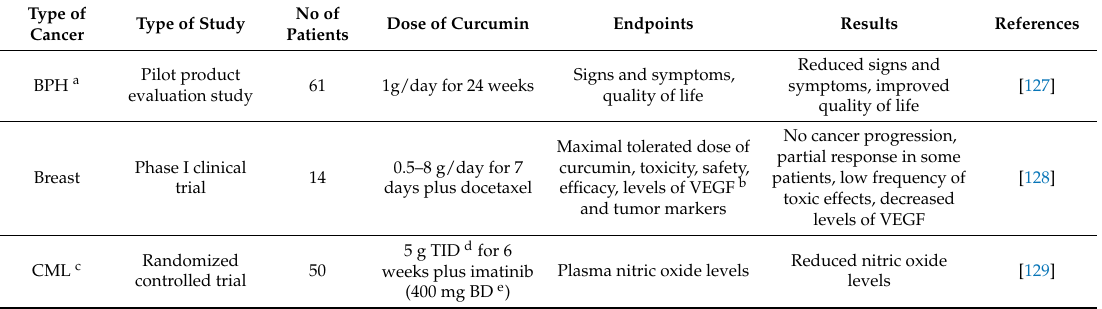
Table 3. Clinical studies of curcumin in the prevention/treatment of different types of